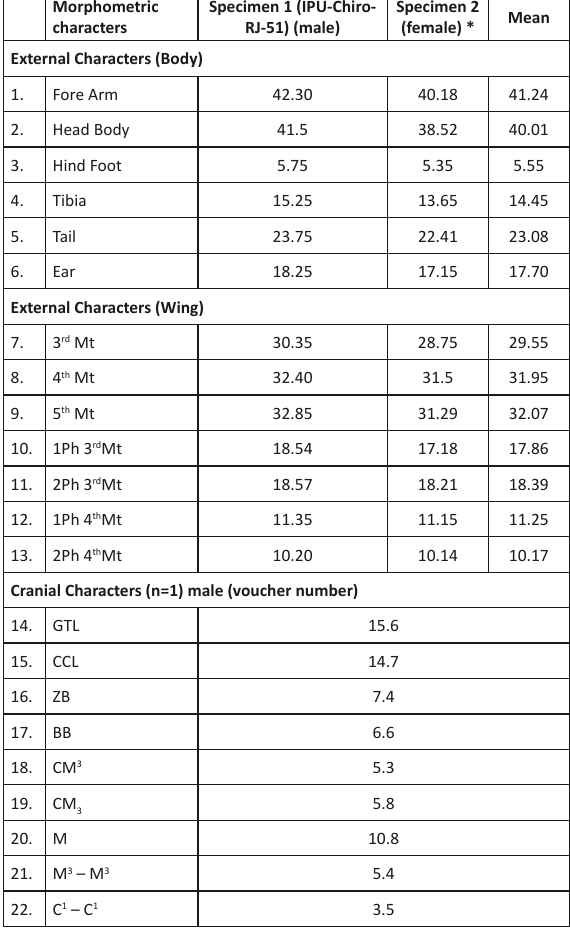
Table 1. Detailed morphological measurements of Hipposideros fulvus (all measurements in mm)